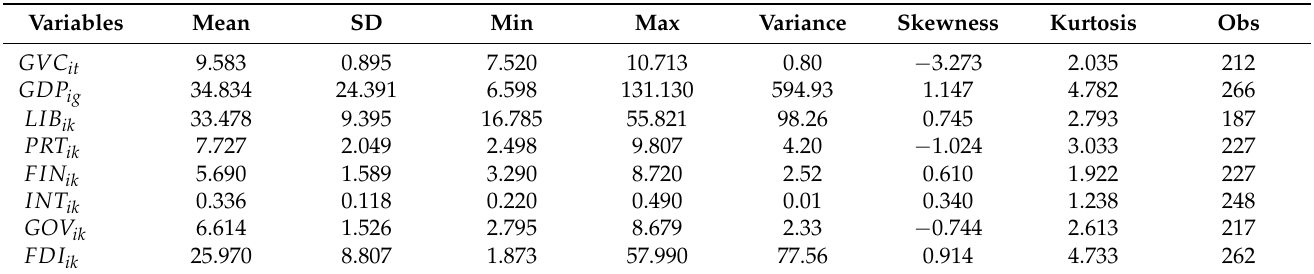
Table 2. Summary Table 2. Summary statistics.